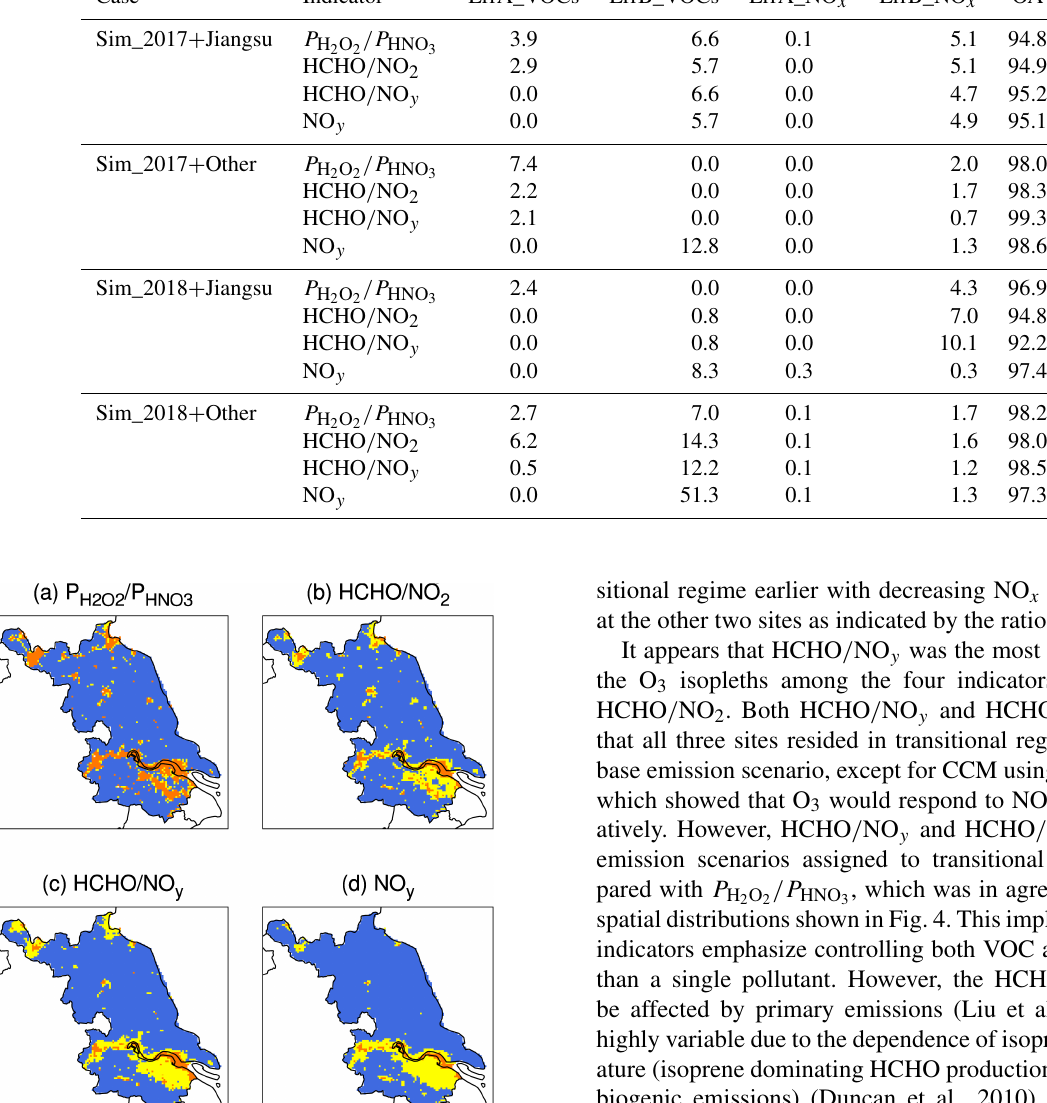
Table 4. Evaluation of the photochemical indicators in the YRD (unit of %). Case